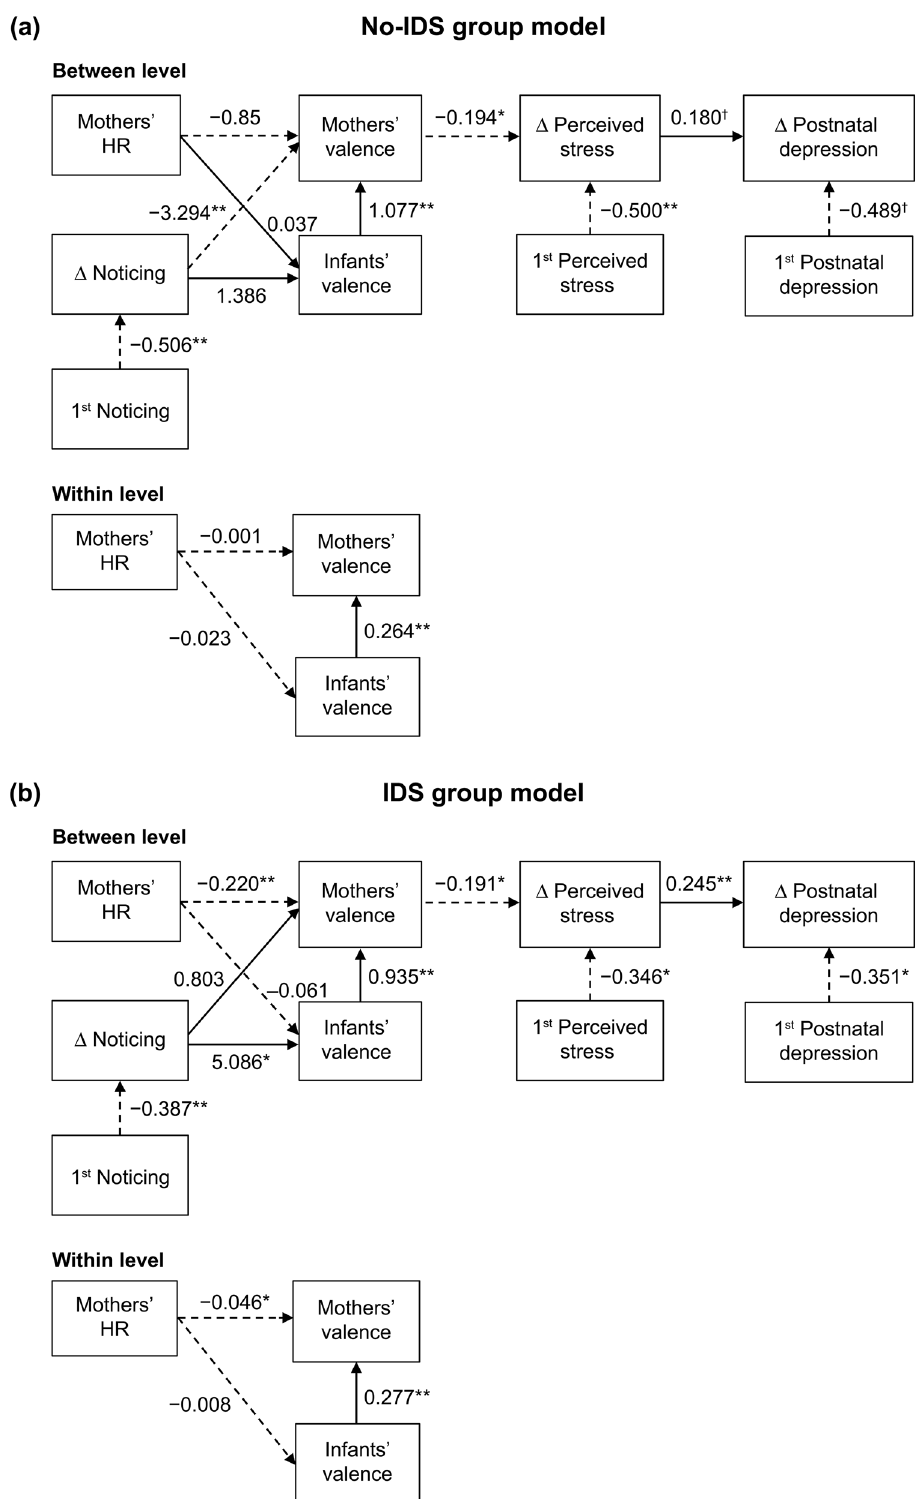
Figure 4. Multiple group multilevel structural equation model. ( a ) No-IDS group model, ( b ) IDS group model. Solid line: Positive effect, Broken line: Negative effect. Estimation: Maximum likelihood estimation, the path of notation unstandardized coefficients. Infants’ valence was evaluated by their mothers. Δ indicates the change score (Session 2 minus Session 1). ** p < .01, * p < .05, † p <